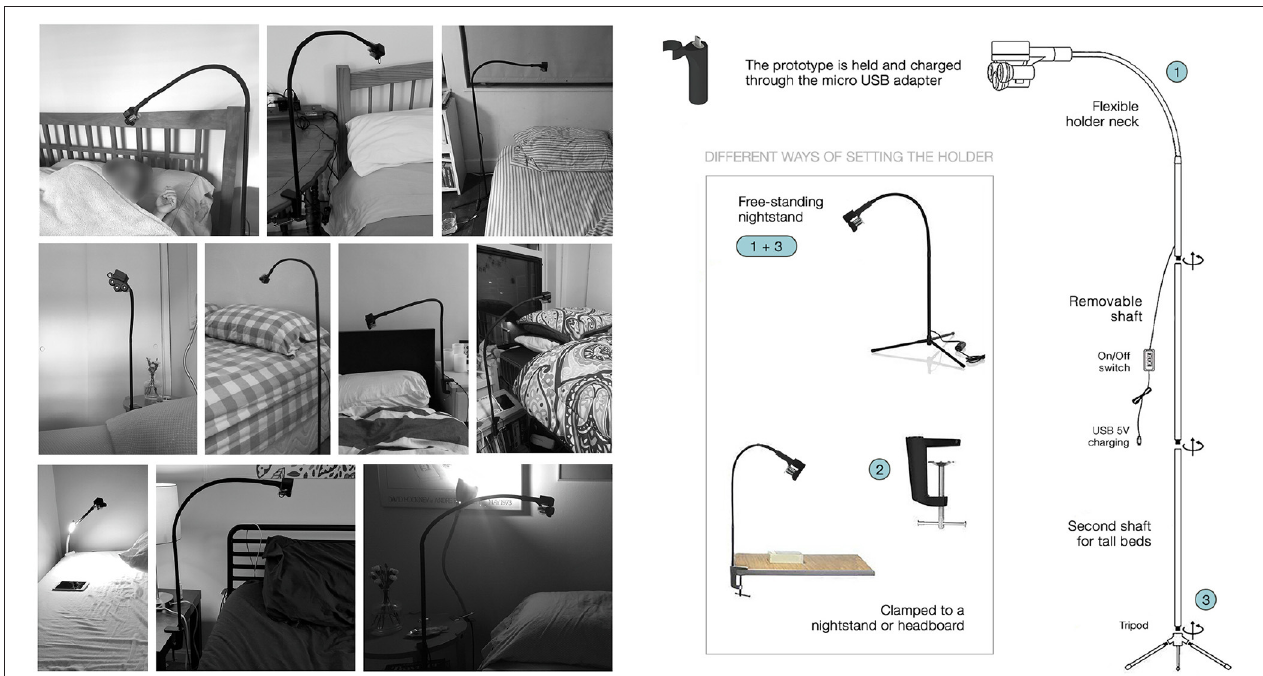
FIGURE 4 | The “sleep holder” charges the device while the user sleeps. The distance between the prototype and the user’s nose can be adapted via the flexible holder head (1). The user can assemble the holder clamped to the nightstand (2) or like a tripod next to the bed (3). On the left, pictures are taken by participants after assembling the prototype to the holder in their